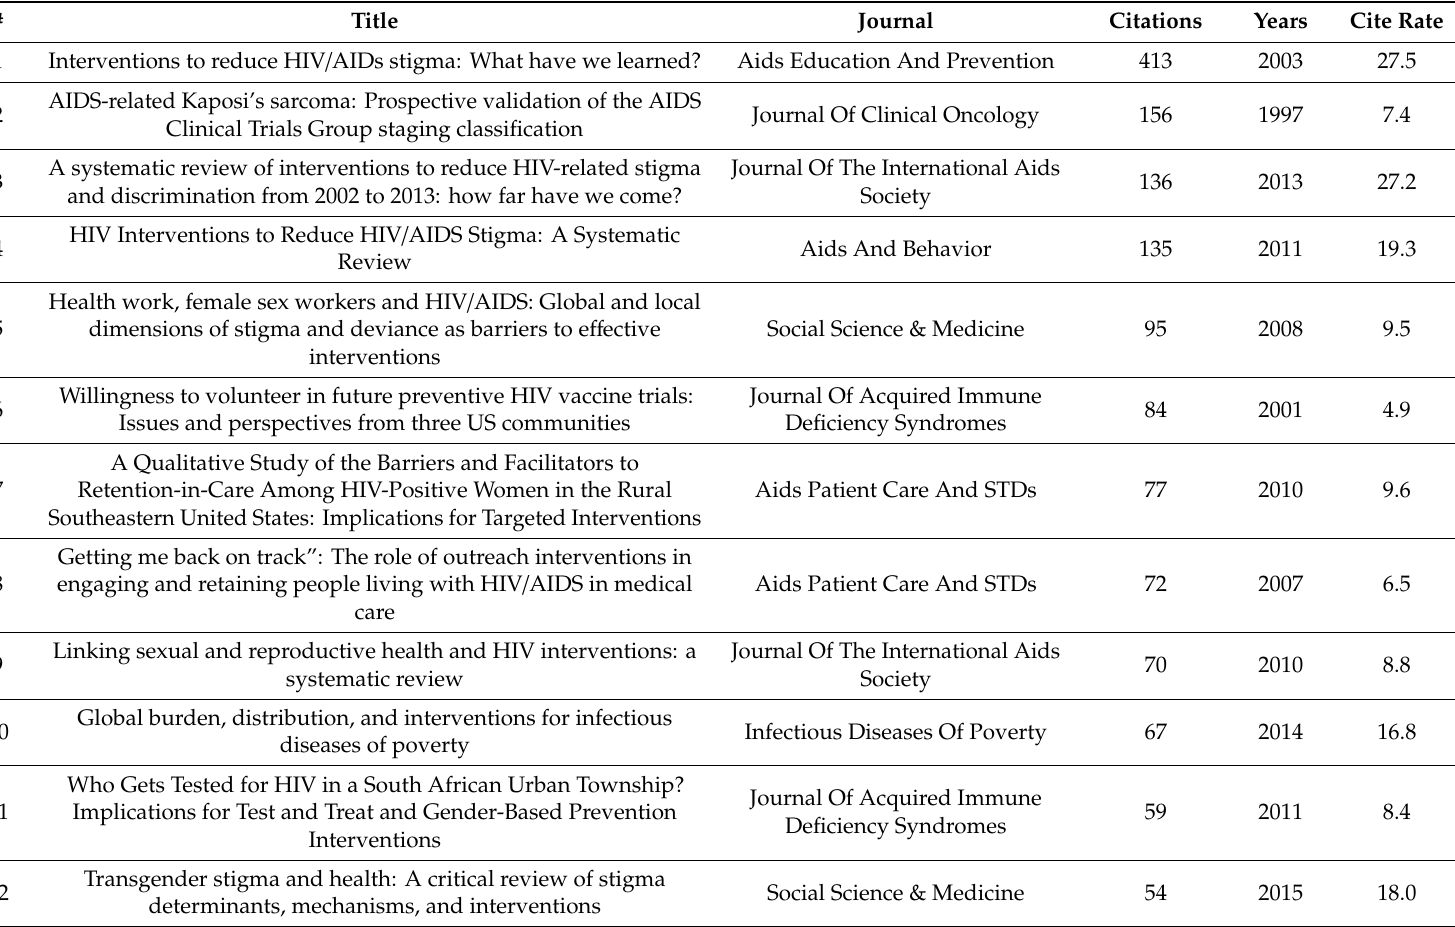
Table 5. Most cited papers mentioning